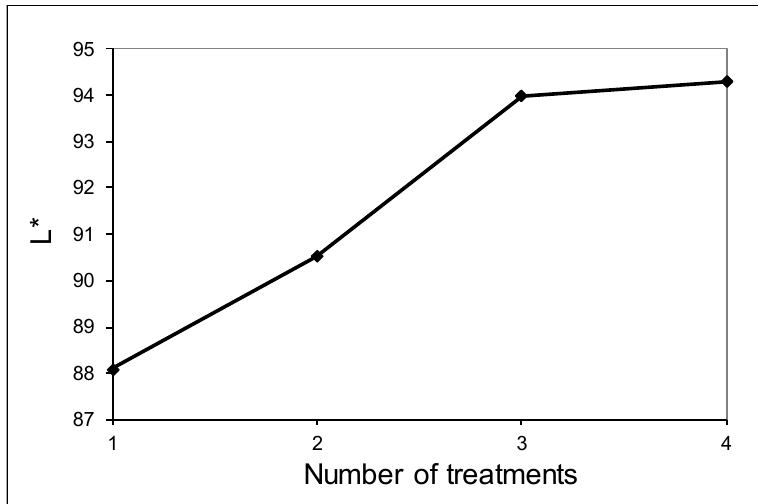
Figure 5. Variation of whiteness index L* with number of cleaning stages.